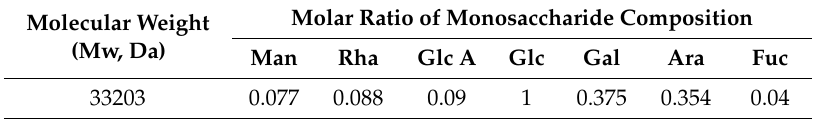
Table 1. Weight and chemical components of the polysaccharides from Athyrium multidentatum (Doll.)